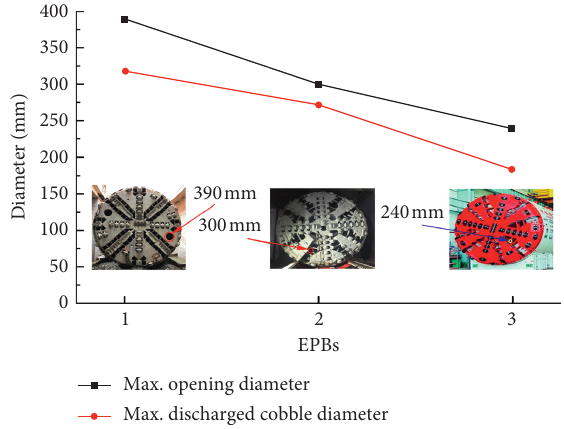
Figure 16: The comparison of the biggest opening size and dis- charged cobble diameter.